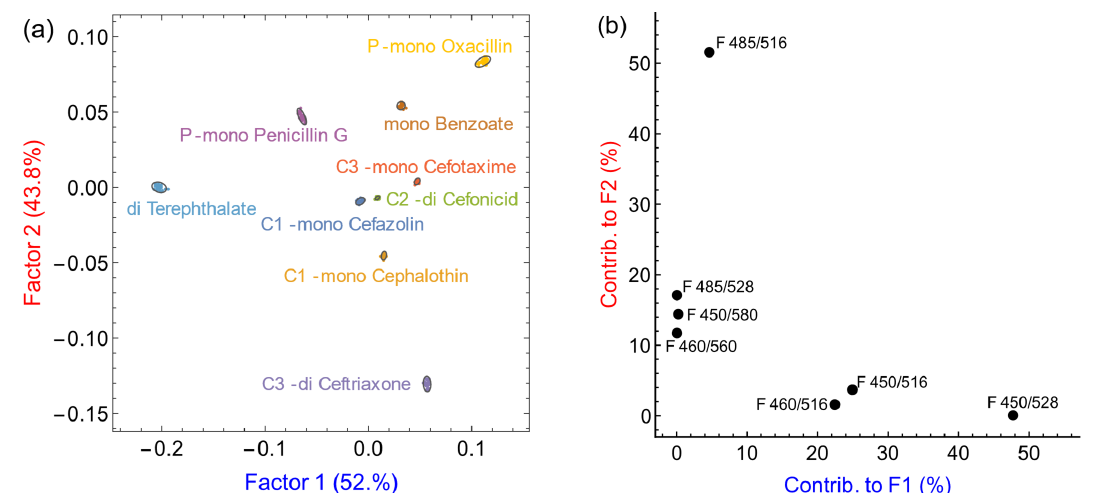
Figure 7. LDA results for qualitative discrimination of nine analytes (two penicillins, five cephalosporins and two reference carboxylates) using [calcein•PAMAM] sensor. ( a ) Scores plot; ( b ) loadings plot. F: fluorescence emission λ ex / λ em . Analyte solutions were prepared at pH 10 and then brought back to pH 7.4 for β -lactam ring hydrolysis. The same set of raw measurements was used as in Figure 5, but only the seven most important measurements were retained, and dye clusters were removed clarity. [calcein] = 6.36 μ M, [PAMAM G5] = 2.13 μ M, [analytes] = 5.0 mM. Performed in 50 mM aqueous HEPES buffer, T = 25 °C.